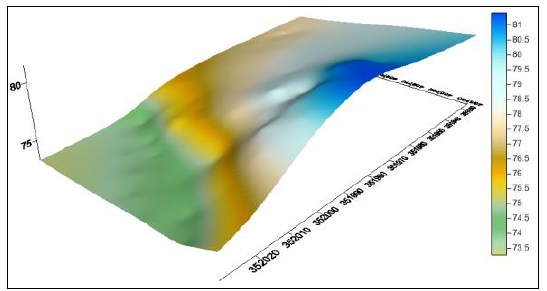
Figure 7. DTM generated from GCPs for mixed forest area